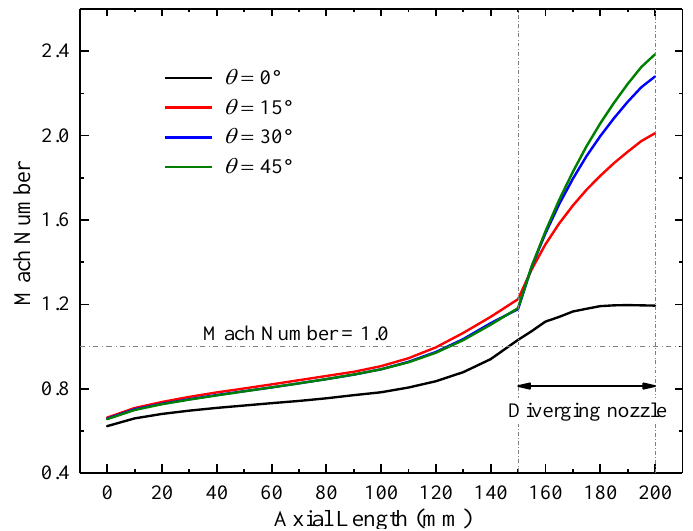
Figure 22. The Mach number in different axial cross-sections of the RDC at t = 3980 μs.